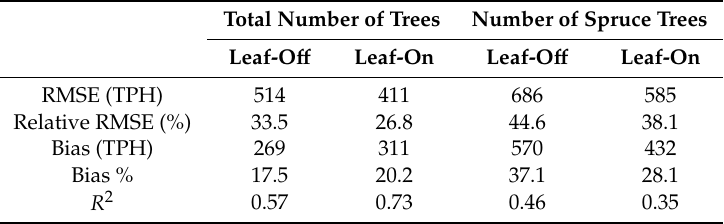
Table 7. Evaluation of the total and spruce tree densities among all sample plots ( n = 15) (TPH = Trees per hectare).